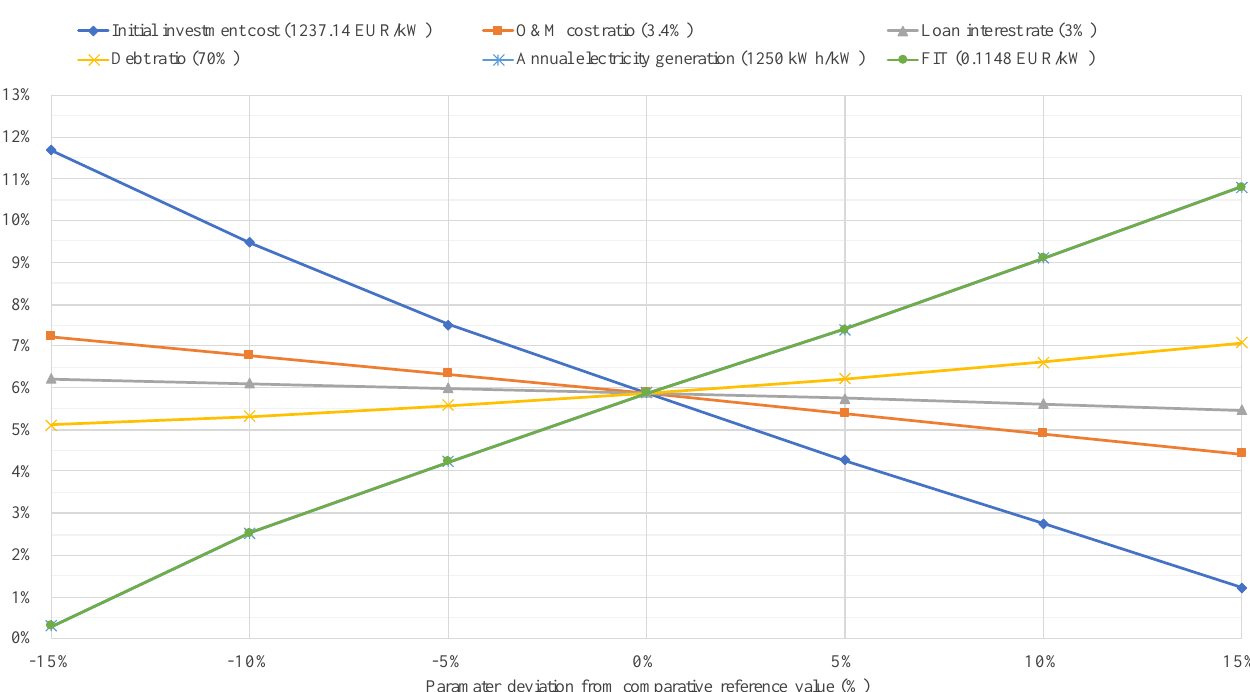
Figure 7. Sensitivity of equity IRR for a 250 kW rooftop PVS with the contract in 2030. Source: self-elaboration.